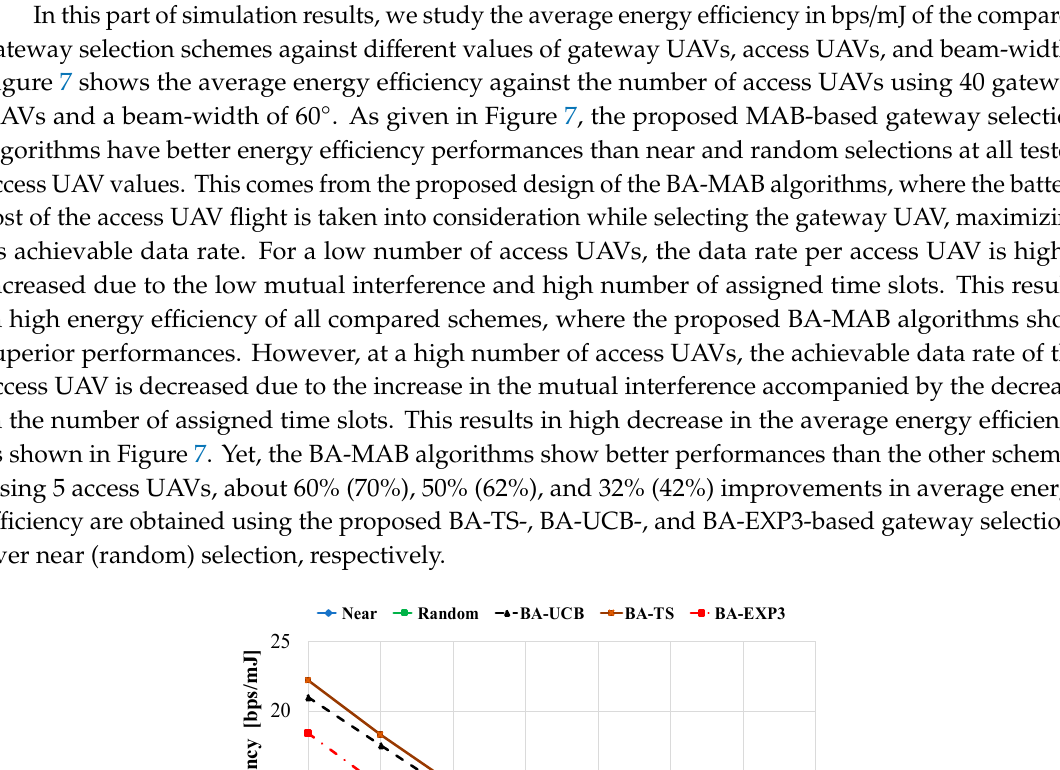
Figure 8. Average energy efficiency against the number of gateway UAVs using access UAVs of 20 and a beam-width of 60°.